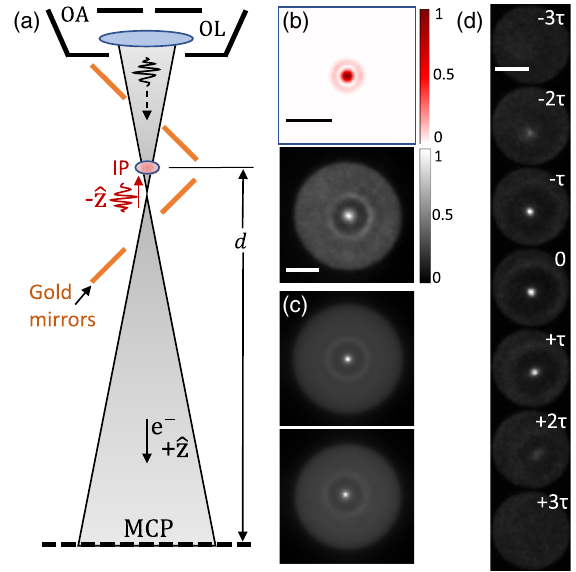
FIG. 2. Ponderomotive electron-light interaction: (a) An SEM objective lens (OL) focuses the electron pulse to a crossover slightly below the interaction plane. The objective aperture (OA) is set to 100 μ m. (b) Top: light intensity distribution (scale bar 93 μ m) before being demagnified ( 5 ×) to the interaction plane. Bottom: observed electron intensity distribution (scale bar 1 mm) at the detector plane. (c) Wave optics (top) and ray optics (bottom) simulations of the detected electron beam shown in (b). (d) Detected electron distributions (scale bar 1.6 mm) when delaying the laser pulse with respect to the electron pulse by multiples of τ ¼ 666 fs. The delay causes the interaction to take place in a plane where the light is not